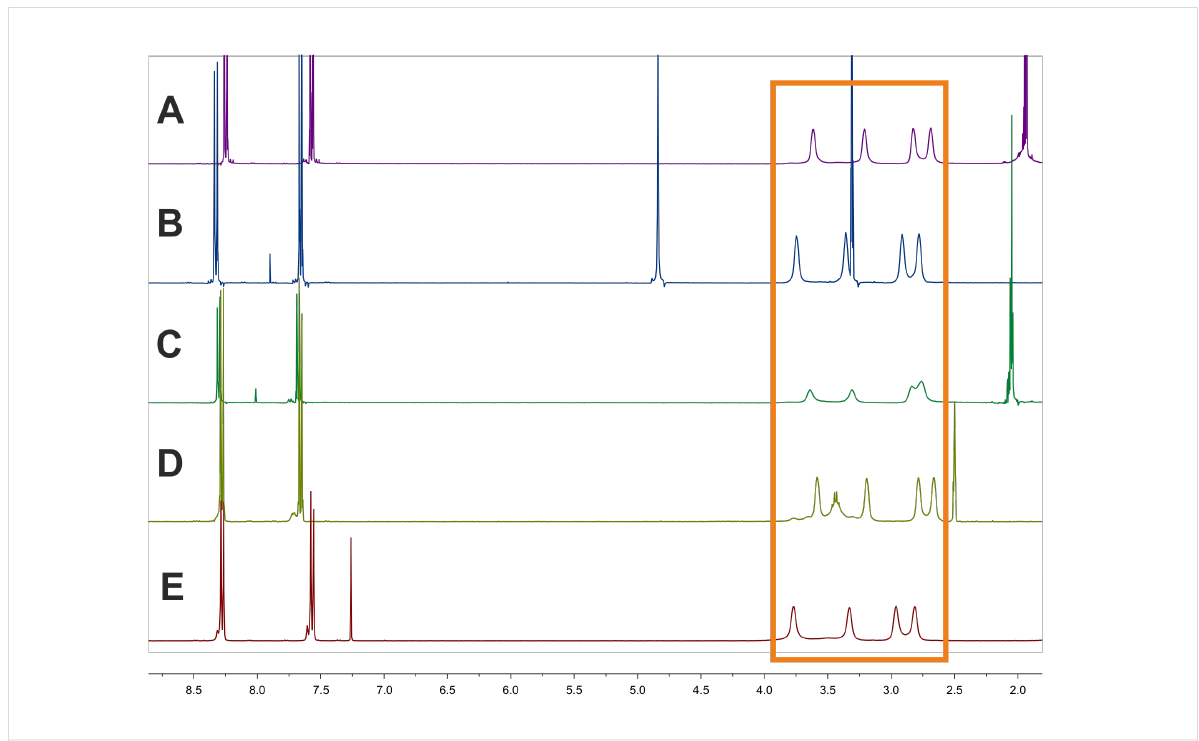
Figure 1: 1 H NMR spectra of compound 3a measured in five different solvents: (A) CDCl 3 , (B) DMSO- d 6 , (C) acetone- d 6 , (D) methanol- d 4 and (E) acetonitrile- d 3 (orange: region of interest).